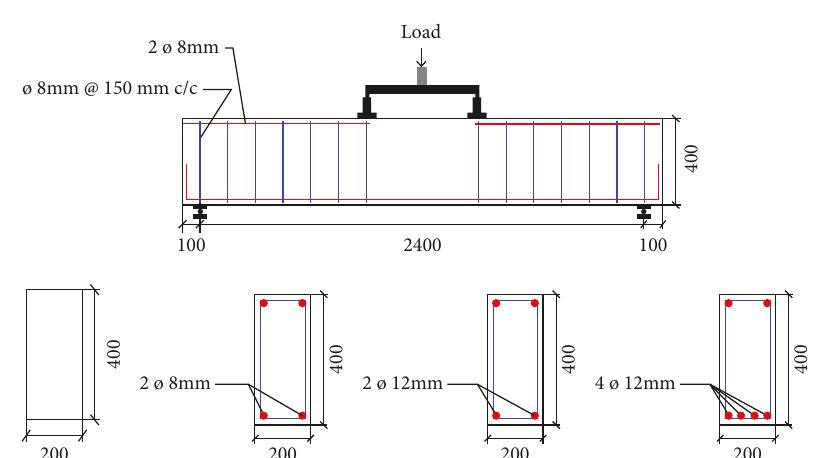
Figure 6: Large beams reinforcement